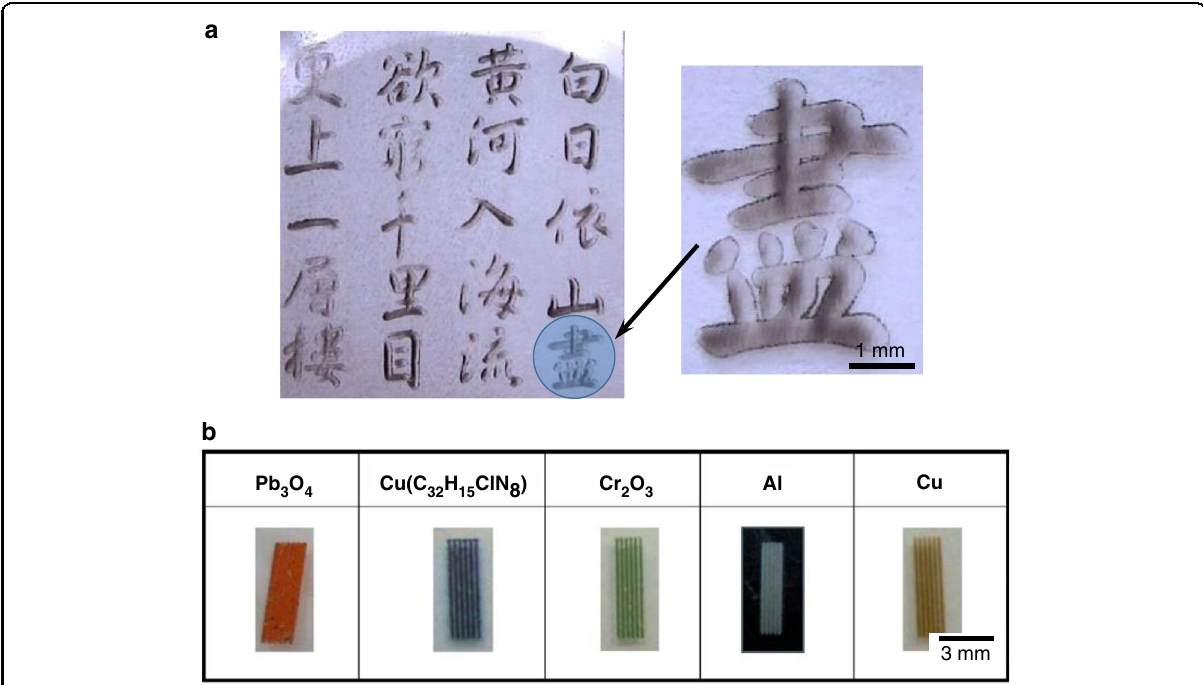
Fig. 5 Laser printing and color marking of transparent materials by LIPAA. a Microscopy images of a Chinese poem printing on glass substrate 50 . b Laser color marking on silicate glass substrates using different targets of Pb 3 O 4 for red, [Cu(C 32 H 15 ClN 8 )] for blue, Cr 2 O 3 for green, Al for white, and Cu for brown 65 . Figure a reproduced with permission from ref. 50 , © (2001) Copyright Society of Photo-Optical Instrumentation Engineers (SPIE), and b from ref. 56 , © 2007 IOP Publishing